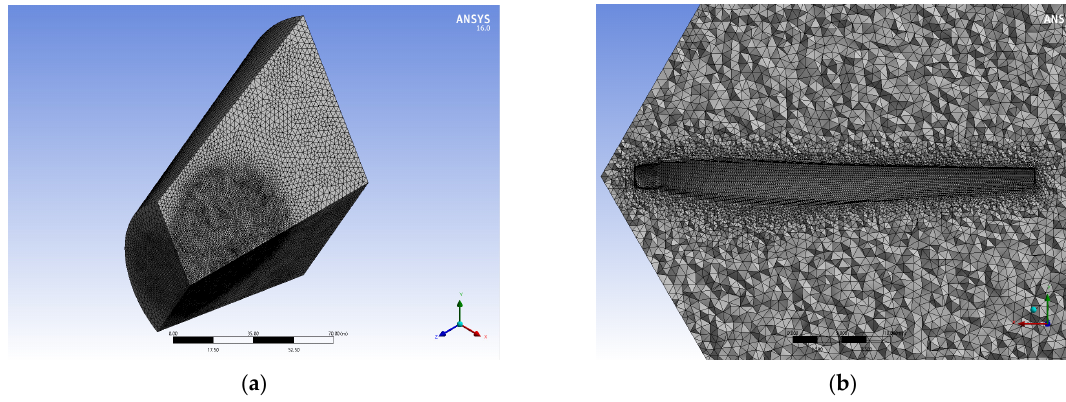
Figure 3. ( a ) Hybrid mesh and ( b ) detail of the mesh around the blade.